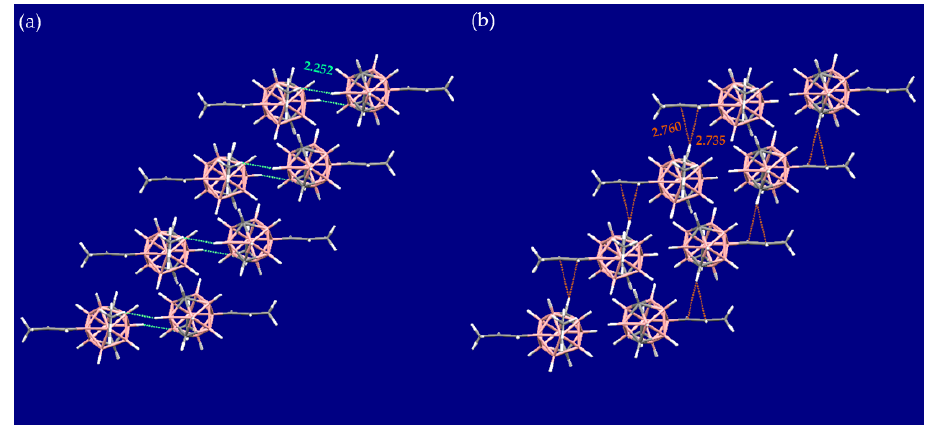
Figure 7. Network presentation of 12 showing all intermolecular contacts as dashed lines: ( a ) C-H … H- Figure7. Networkpresentationof 12 showingallintermolecularcontactsasdashedlines: ( a )C-H ... H-B B and ( b ) C c -H … π interactions. and ( b ) C c -H ... π interactions.